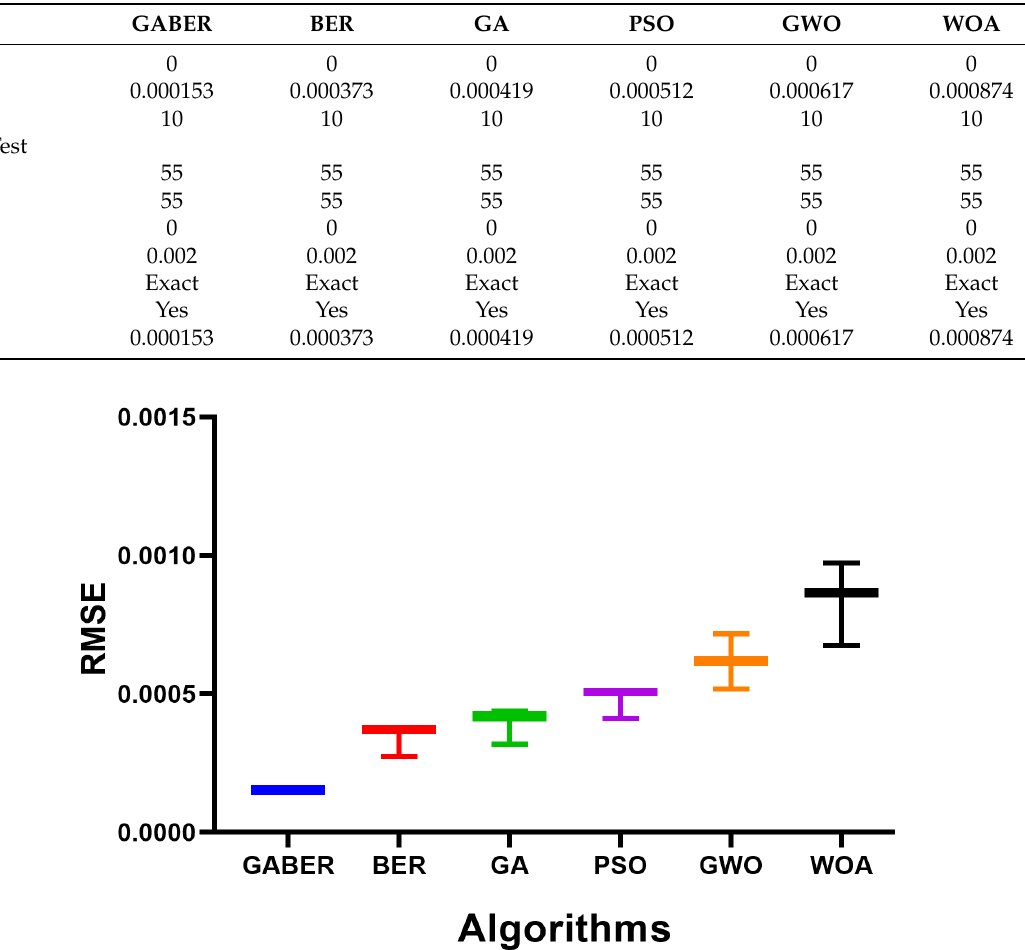
Table 18. Wilcoxon test applied to the results achieved by the proposed optimized ensemble when applied to the solar radiation dataset.